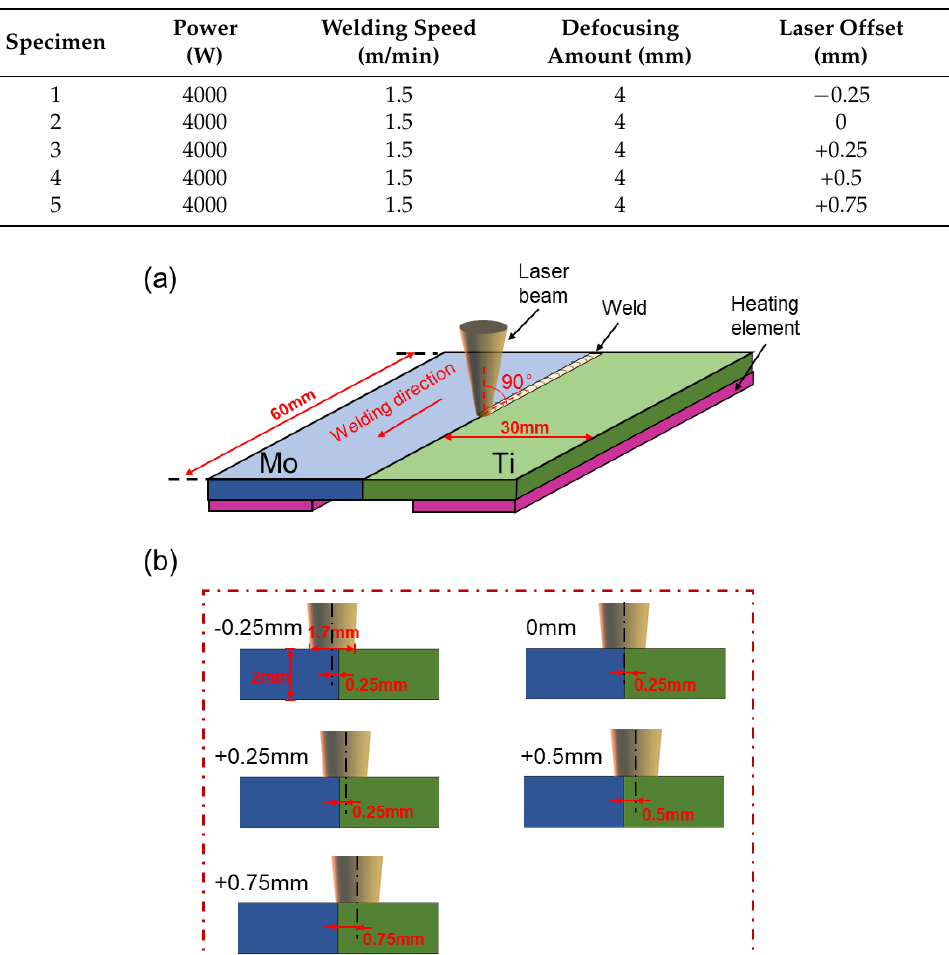
Figure 1. Cross-sectional microstructure of the BMs of ( a ) Molybdenum and ( b ) Titanium. Table 1. Parameters used in laser beam offset welding of dissimilar Mo/Ti joint.